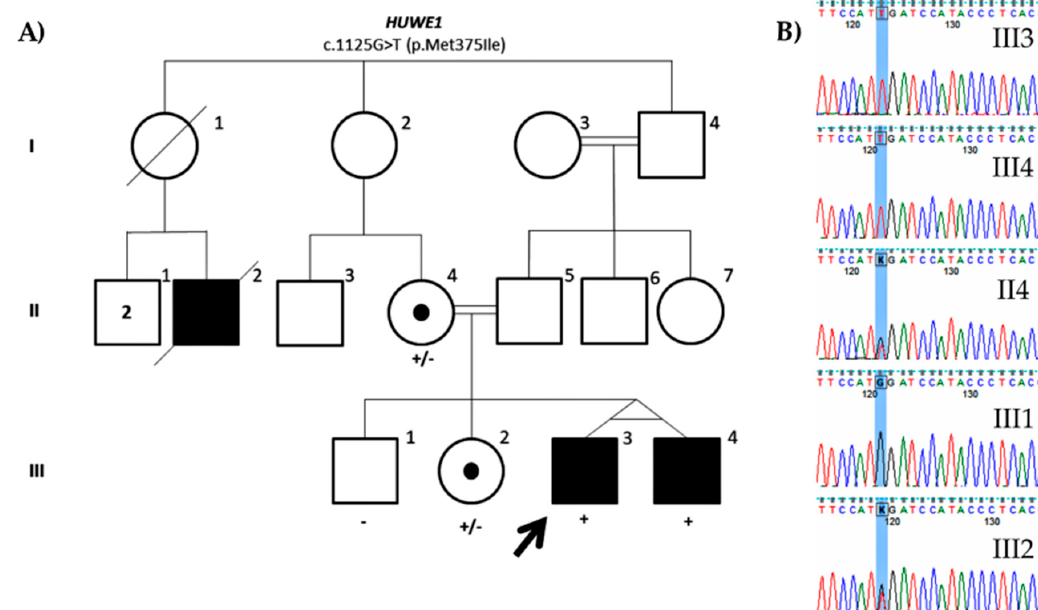
Figure 5. ( A ) Family pedigree of the ID1128 proband. Segregation of the missense variant found in HUWE1 (NM_031407.6: c.1125G > T; p.Met375Ile). ( B ) Partial DNA sequence of the HUWE1 gene. The identified nucleotide change is